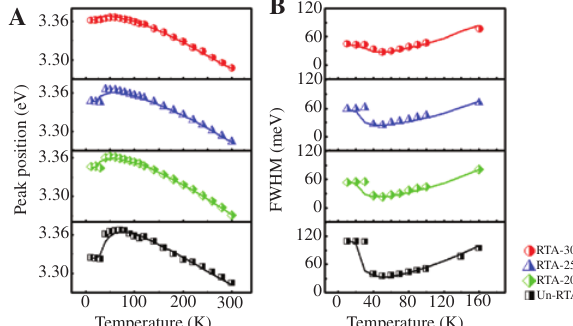
Figure 5: (A) Temperature-dependent peak position of the ZnO/ ZnS NWs before and after annealing. (B) The FWHM parameter of the ZnO/ZnS NWs before and after annealing vs. temperature. The solid lines represent theoretical curve according to the proposed luminescence model of the